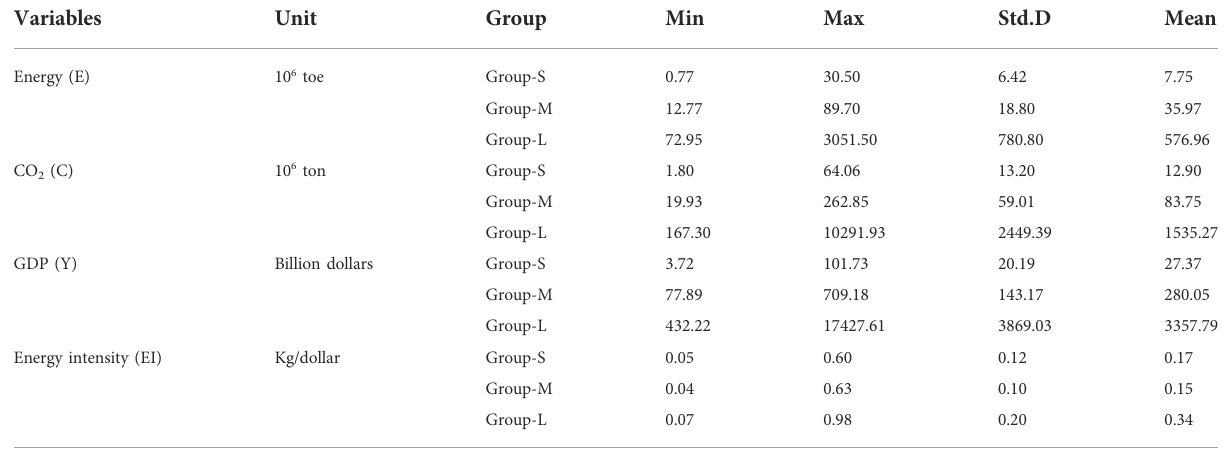
TABLE 2 The statistical characteristics of the key indicators in different groups.